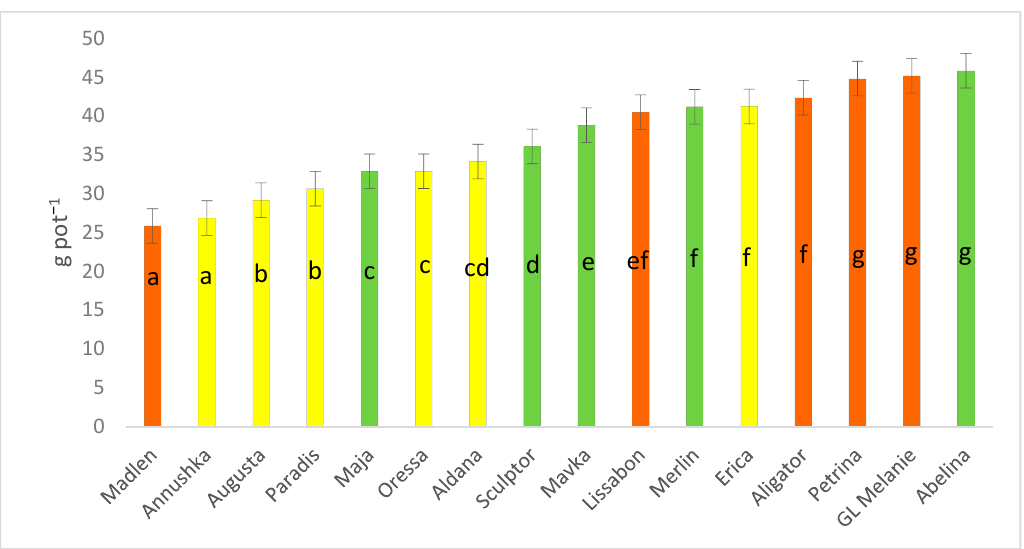
Figure 2. Yield of soybean seeds depending on the cultivar (n = 30); ± LSD ( p ≤ 0.05); different letters mean significant differences in the Tukey test ; yellow bars—group of very early and early cultivars (EC); green bars—group of semi-late cultivars (SC); orange bars—group of late and very late cultivars (LC).